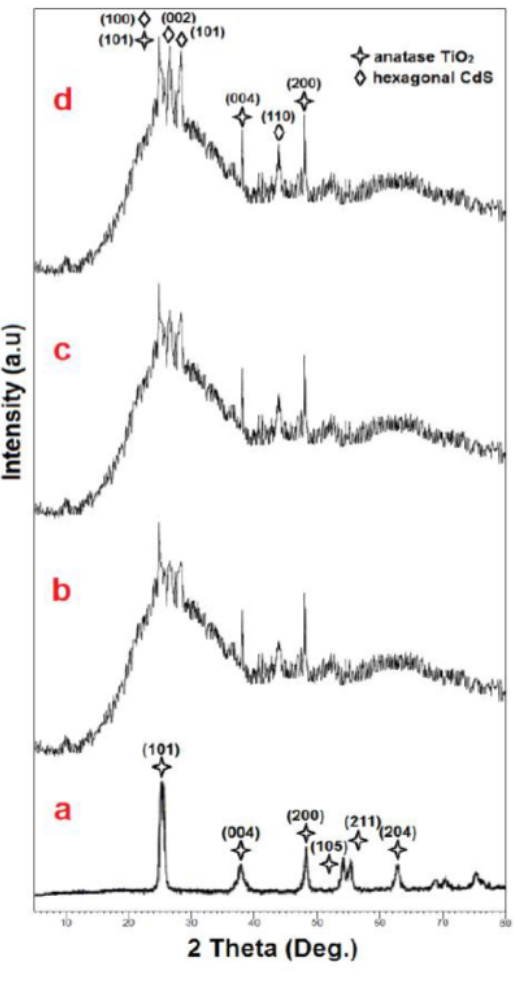
Figure 2: XRD spectra of (a) pure TiO 2 nanofibers, (b) TiO 2 - 0.25CdS, (c) TiO 2 - 0.5CdS, (d) TiO 2 - 1CdS composite nanofibers.